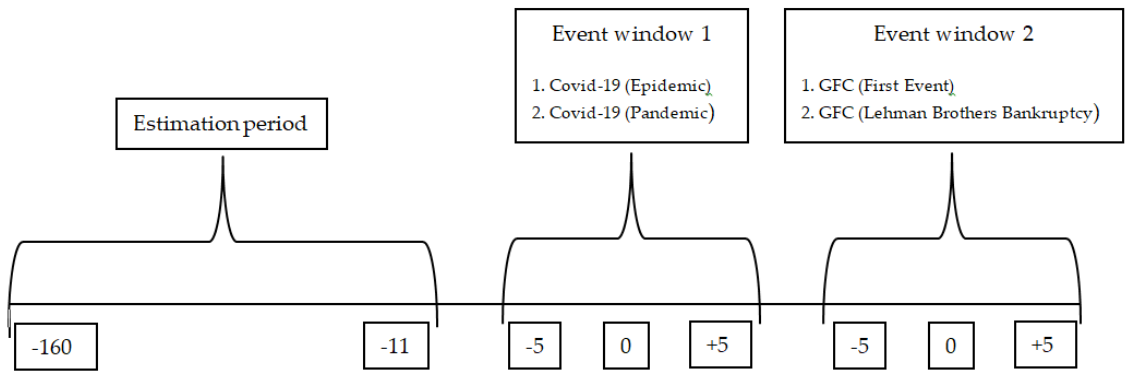
Figure 1. Timeline for Event Study.